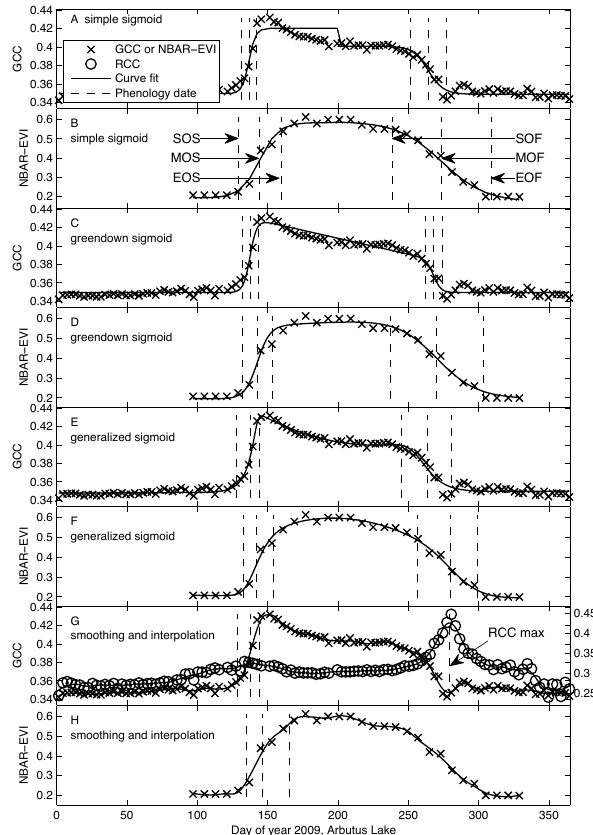
Figure 3. Example comparison of the simple sigmoid, green-down sigmoid, generalized sigmoid, and smoothing and interpolation ap- proaches for 1 year of GCC and NBAR-EVI data. Phenology date estimates represent start of spring, middle of spring, and end of spring (SOS, MOS, and EOS, as shown in panel b ). The simple sig- moid, green-down sigmoid, and generalized sigmoid models also have start of fall, middle of fall, and end of fall (SOF, MOF, and EOF, as shown in panel b ). A single fall phenology date is identi- fied from RCC using the smoothing and interpolation model (RCC max, as shown in panel g